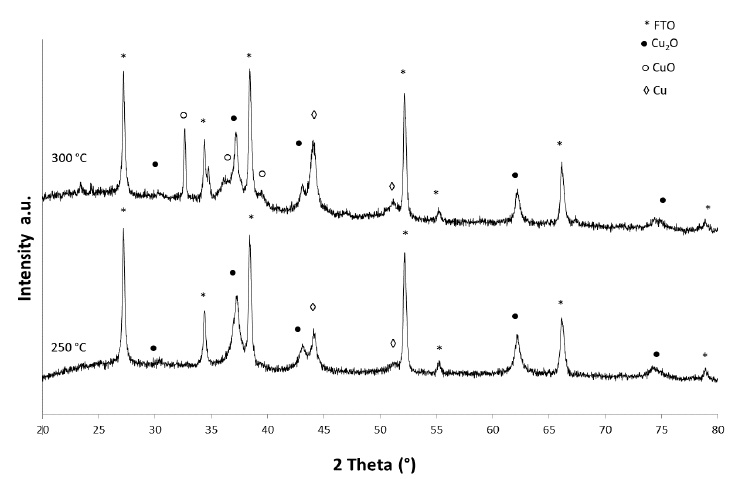
Figure 12. XRD patterns of the Cu 2 O and Cu 2 O/CuO electrodes after PEC test.